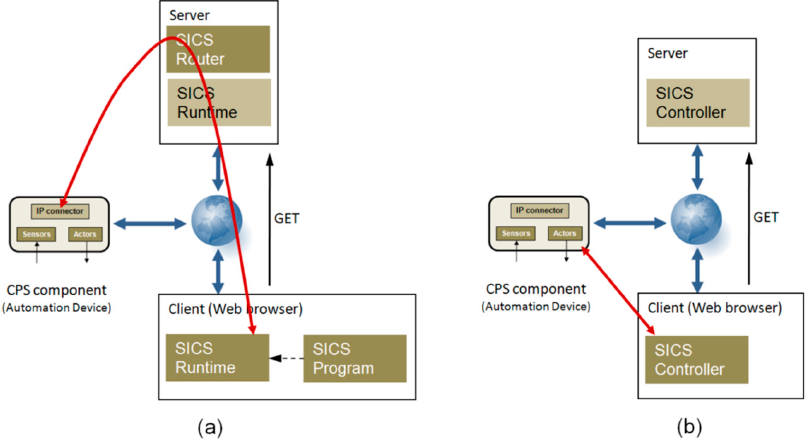
Figure 6. Component structure and communication paths for client-based SICS solutions. ( a ) Client-based mixed mode (CMM); ( b ) client mode (CM).